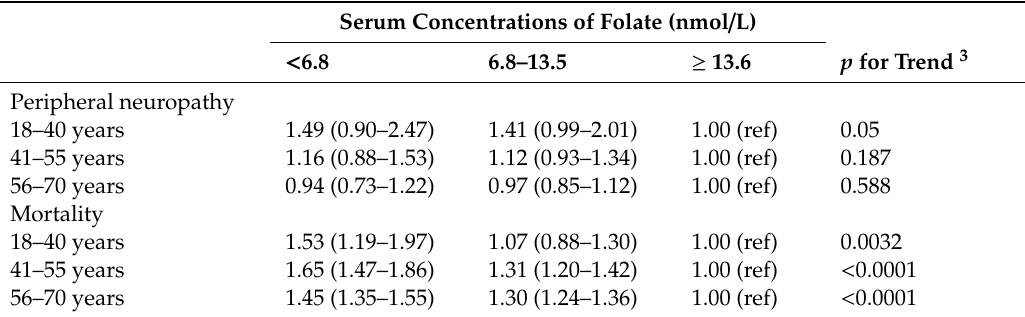
Table 3. Hazard ratios (95% CI) of peripheral neuropathy and mortality according to the categories of serum folate concentrations and age group after censoring an additional two years of follow-up. 1,2 . Serum Concentrations of Folate (nmol / L) < 6.8